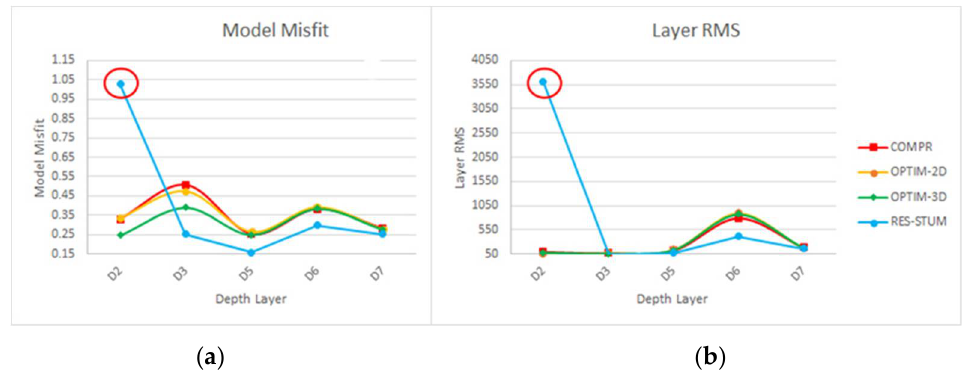
Figure 10. Model misfit ( a) and layer RMS ( b ) values for FULL array among comprehensive (red colored line), Optim-2D (yellow colored line), Optim-3D (green colored line) and Res-STUM (blue colored line) data set. Outliers indicated with red circles.